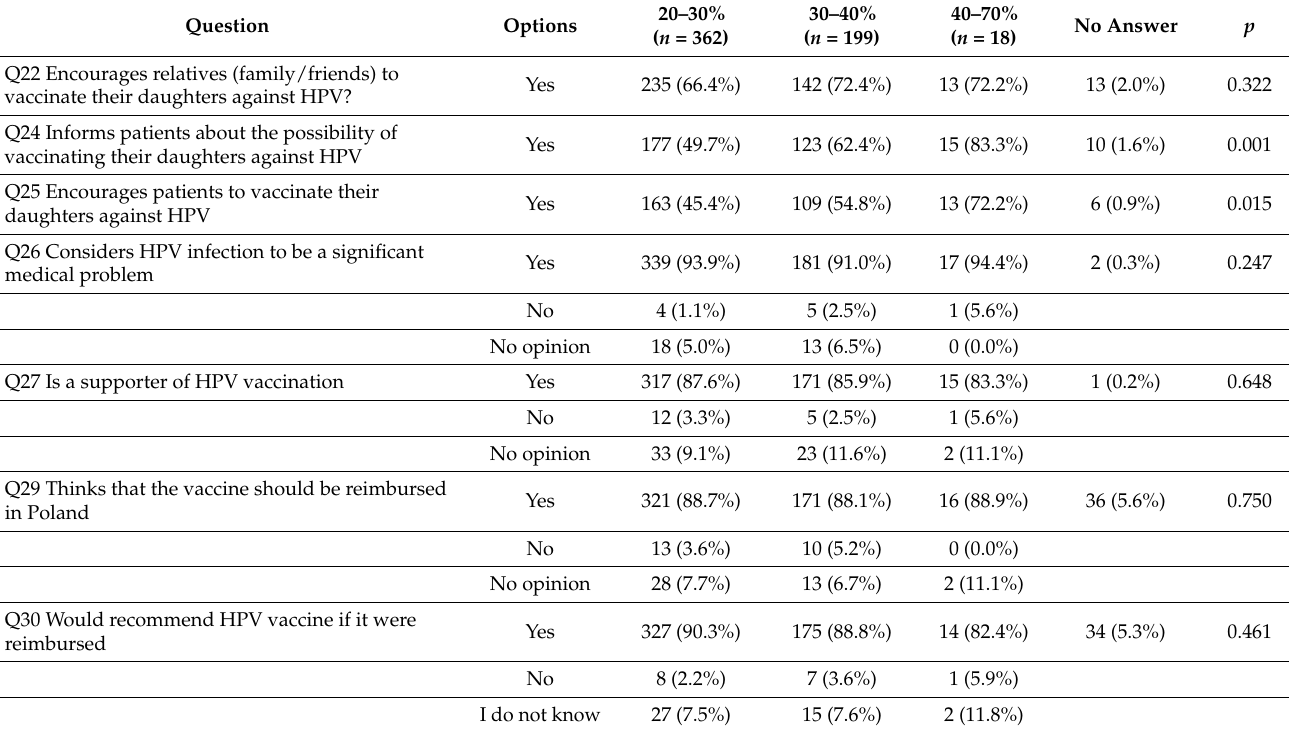
Table 7. Doctors’ attitude to HPV vaccinations depending on